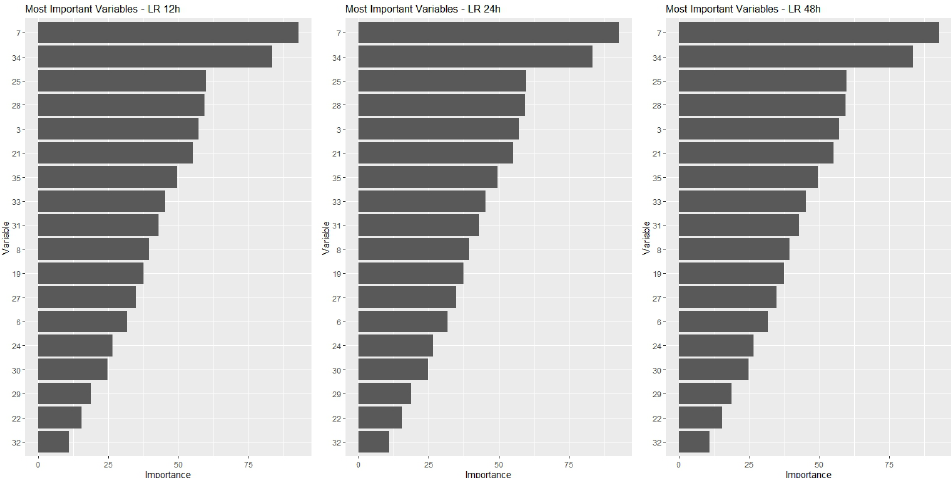
Figure 5. Most Important Variables for MLP—Multilayer Perceptron Models.